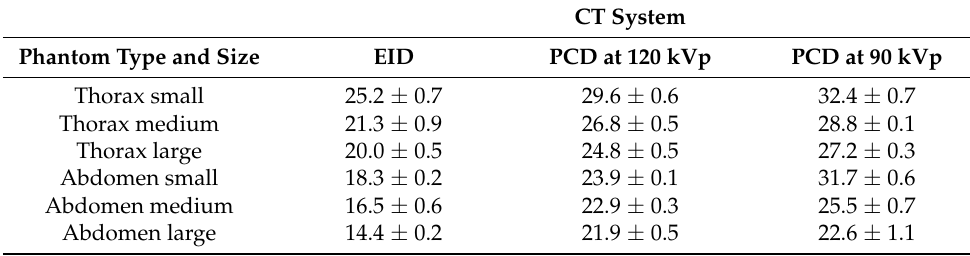
Table 2. Contrast-to-noise-ratios for virtual monoenergetic images at 40 keV of an energy integrating detector (EID) and a photon-counting detector (PCD)-based CT system. Iterative reconstruction technique was turned off.